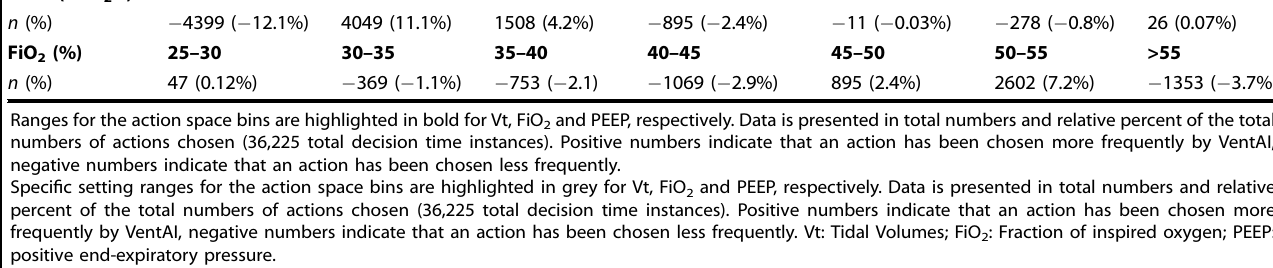
Table 2. Distribution of the chosen action by VentAI in comparison to the clinician ’ s performance (MIMIC-III dataset).